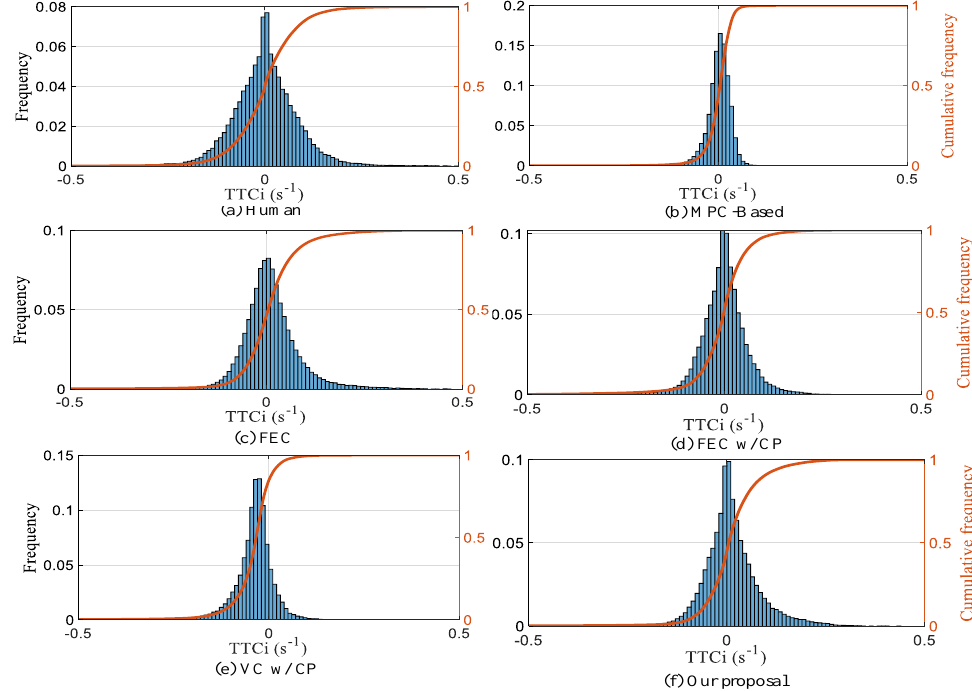
Figure 12. Comparison of decision performance of different strategies in single-scenario US101 set, where ( a – f ) respectively correspond to space headway, speed, acceleration, jerk, THW, and TTCi.